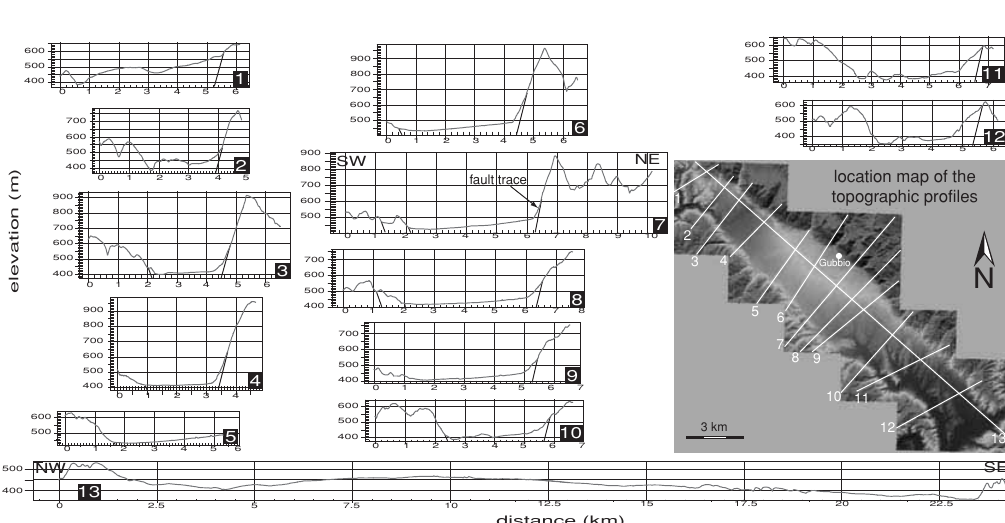
Fig. 7. Topographic profiles across and parallel to the Gubbio Basin performed by means of the 5 m resolution DEM. The position of the Gubbio Fault trace is shown in the